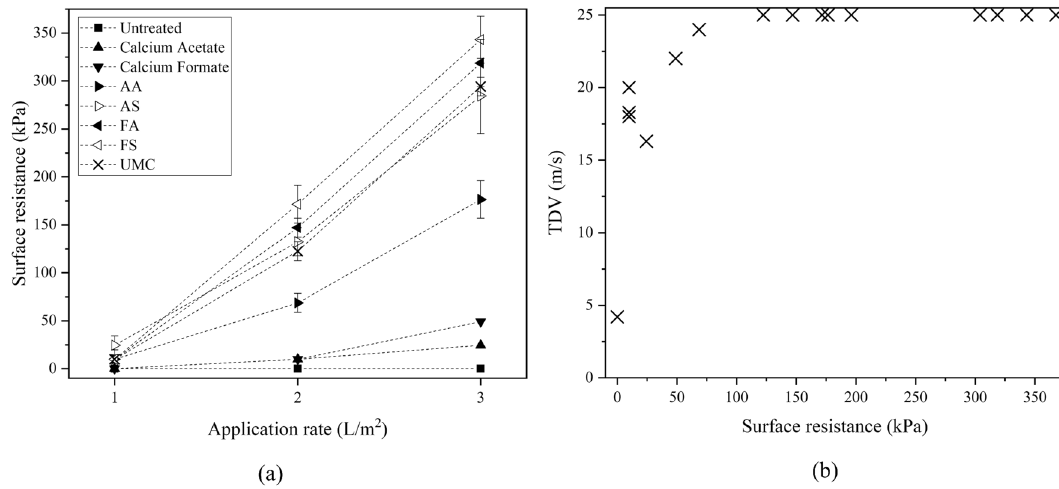
Figure 13. ( a ) Surface resistance versus application rate. ( b ) TDV versus surface